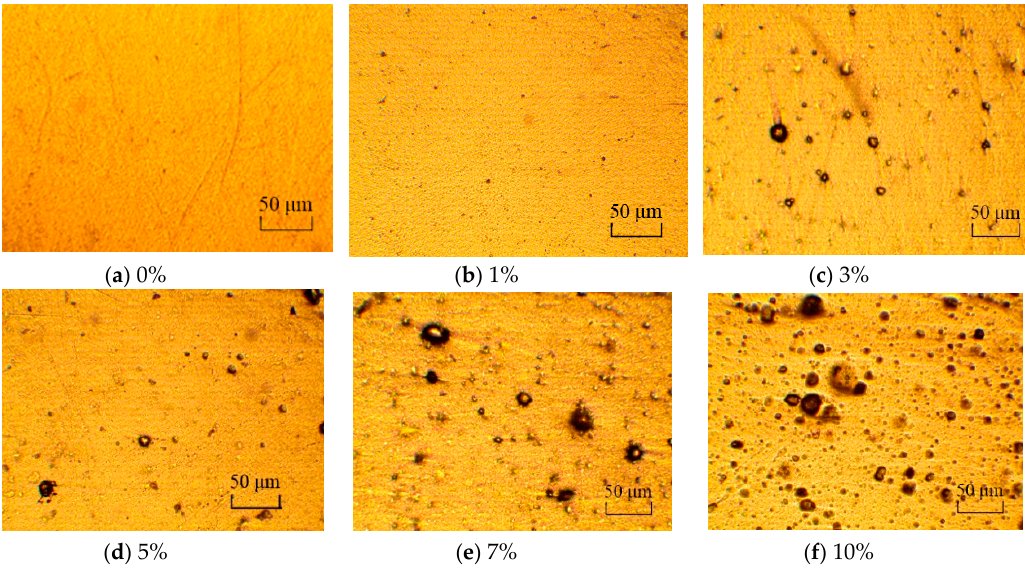
Figure 4. The oxygen scavenger dispersion under different content. ( a ) 0%; ( b ) 1% ; ( c ) 3% ; ( d ) 5% ; ( e ) 7% ; ( f ) 10% .